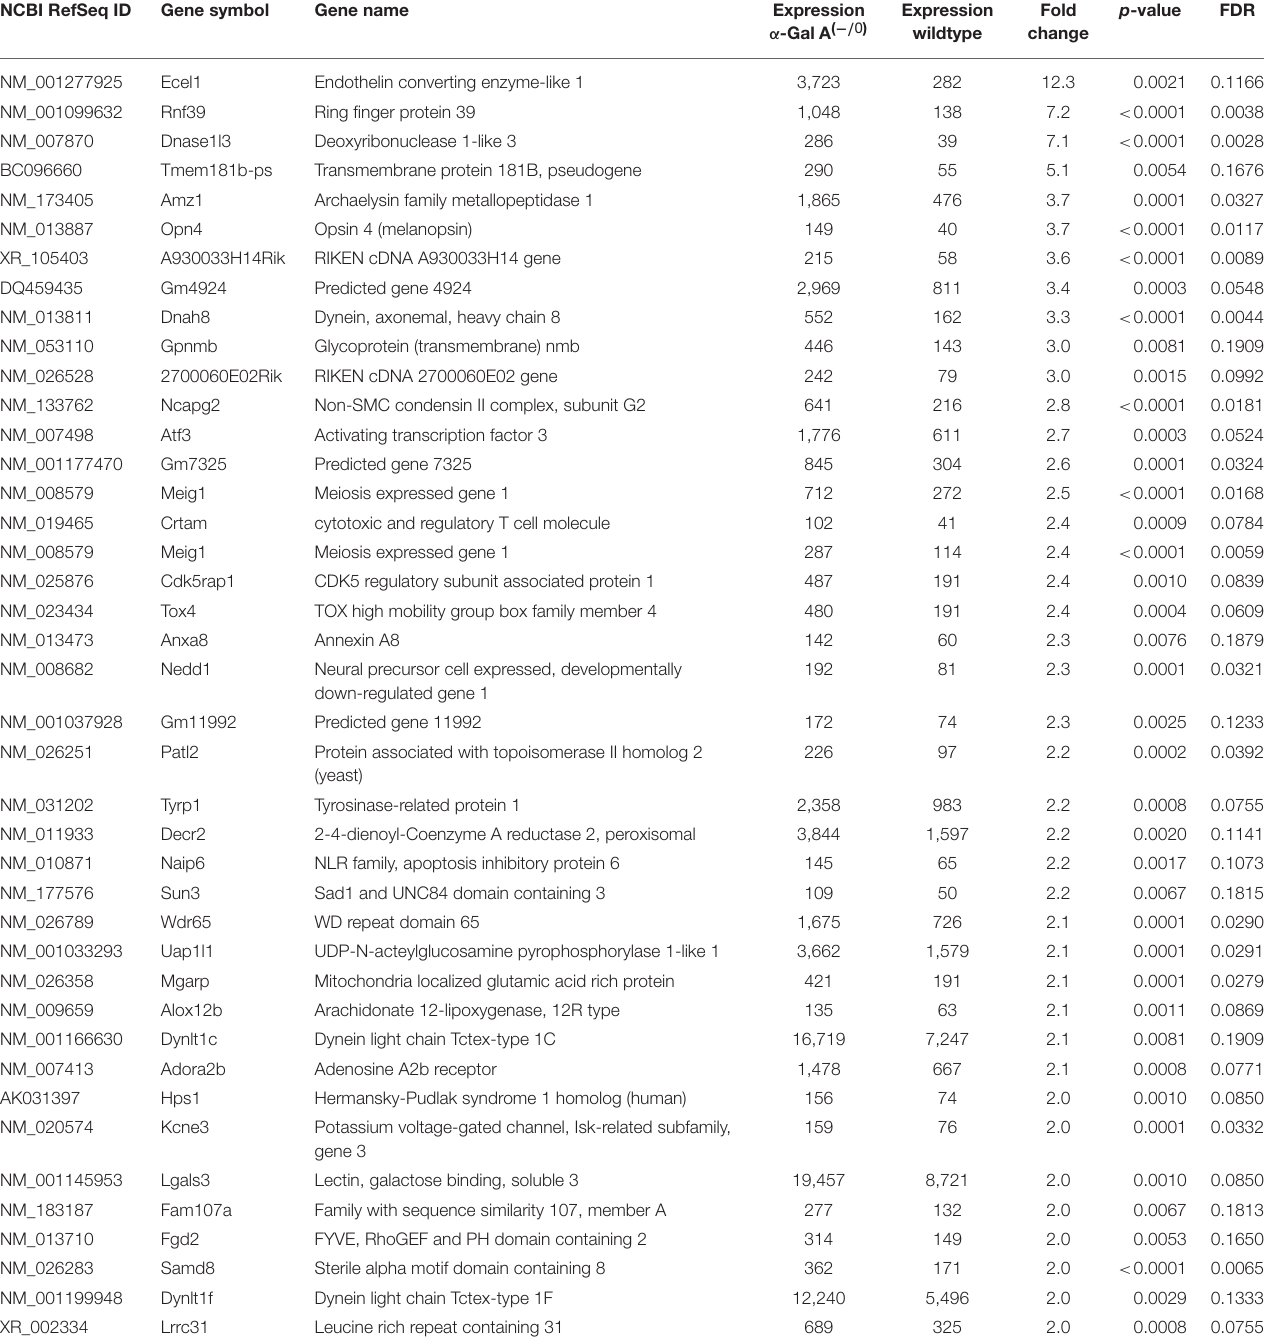
TABLE 1 | Raw expression values, fold changes and statistical analysis for significantly upregulated